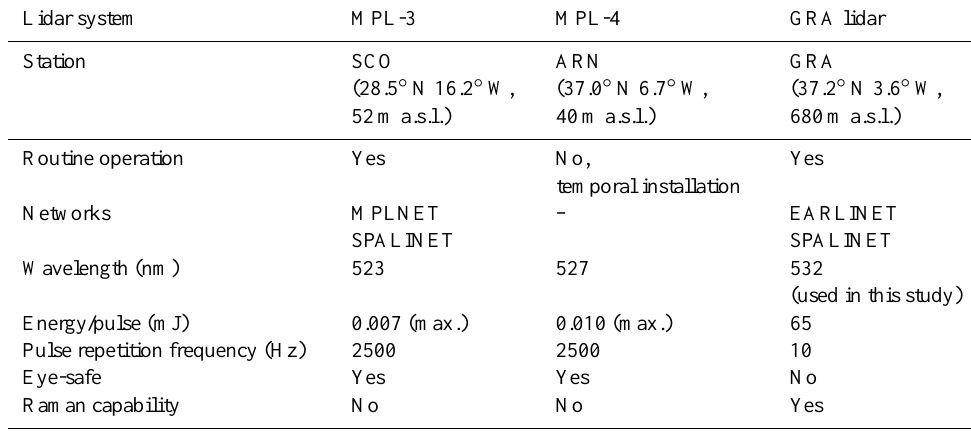
Table 1. Main characteristics of the three lidars used in this study. Lidar